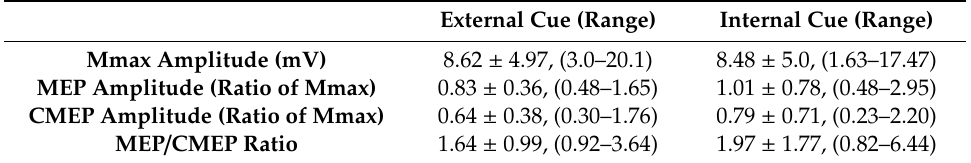
Table 3. Mean ± SD of the corticospinal excitability (CSE), collapsed across trials (trial 1 to trial 6), for external and internal contraction conditions. Data presented as mean (M), standard deviation (SD), and range. External Cue